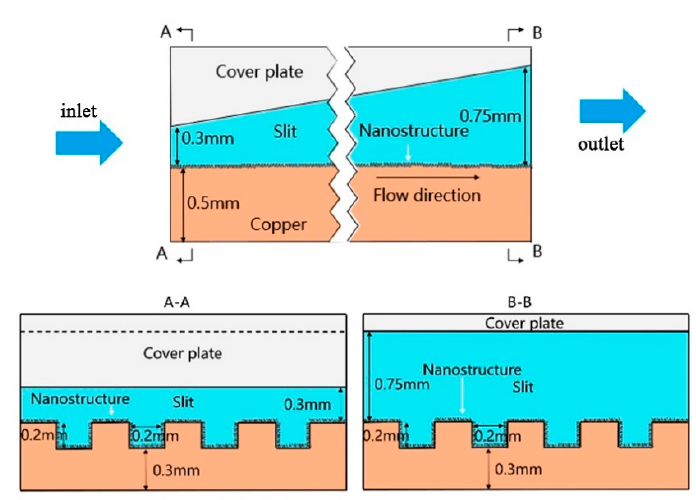
Figure 3. Schematic diagram of the open microchannel flow passage.